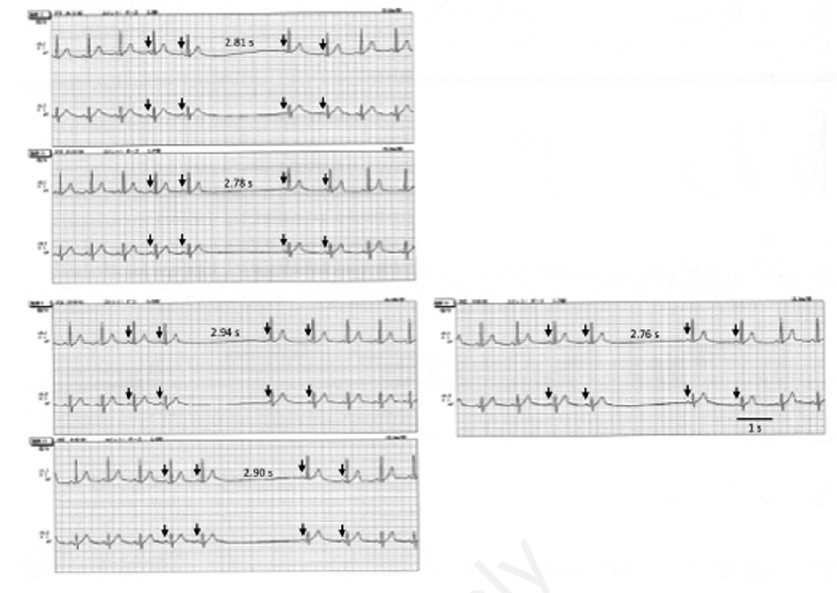
Figure 1. Holter recording on day seven displaying sinus arrest with P wave (arrow) falling off, and 2.94 seconds at the greatest R-R interval. There were five pauses